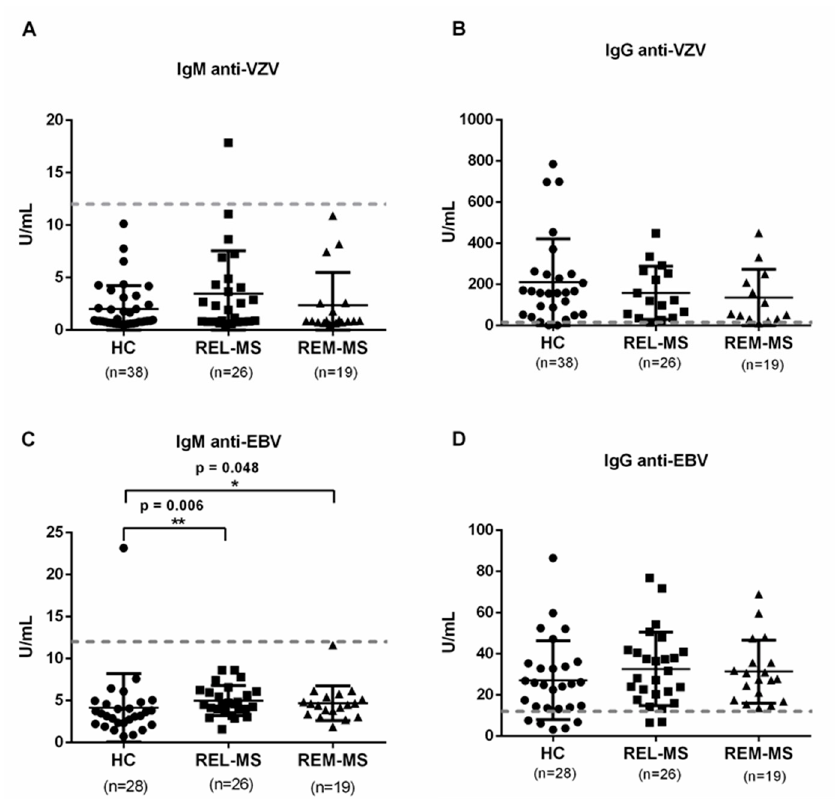
Figure 5. Serum IgM and IgG. Sera from REL-MS, REM-MS patients and HC were collected to quantify antibodies against VZV ( A , B ) and EBV ( C , D ) by Enzyme-linked immunosorbent assay. MS patients had higher concentration of anti-EBV IgM in comparison with HC. Dotted lines indicate the concentration above which a sample is considered positive, according to the manufacturer’s instructions. * p < 0.05, ** p <